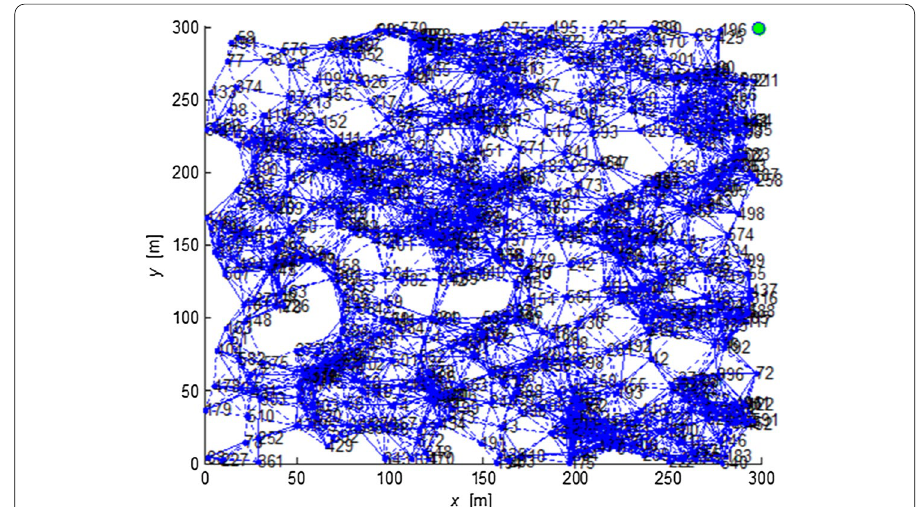
Fig. 4 WSN with 600 nodes and destination at location (300,300)